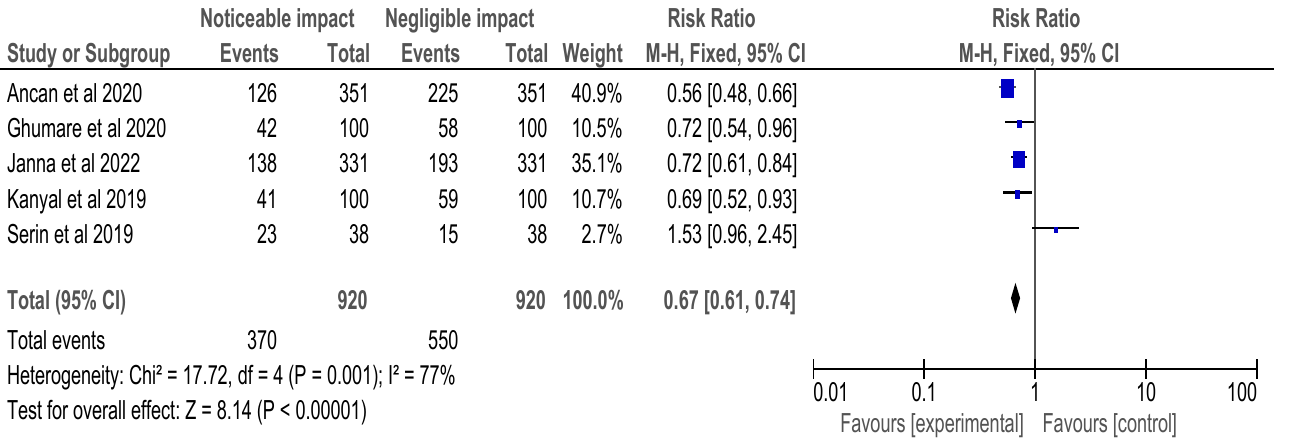
Figure 4. Risk ratio of selected cross-sectional, cohort and retrospective investigations represented on a forest plot after their meta-analysis, in which the noticeable impact of Vitamin B12 interventions compared to their negative to negligible impact was assessed (where the blue dot represents the study with the most weight and the rhombus represents the total weight of the forest plot) [14,23–25,30].